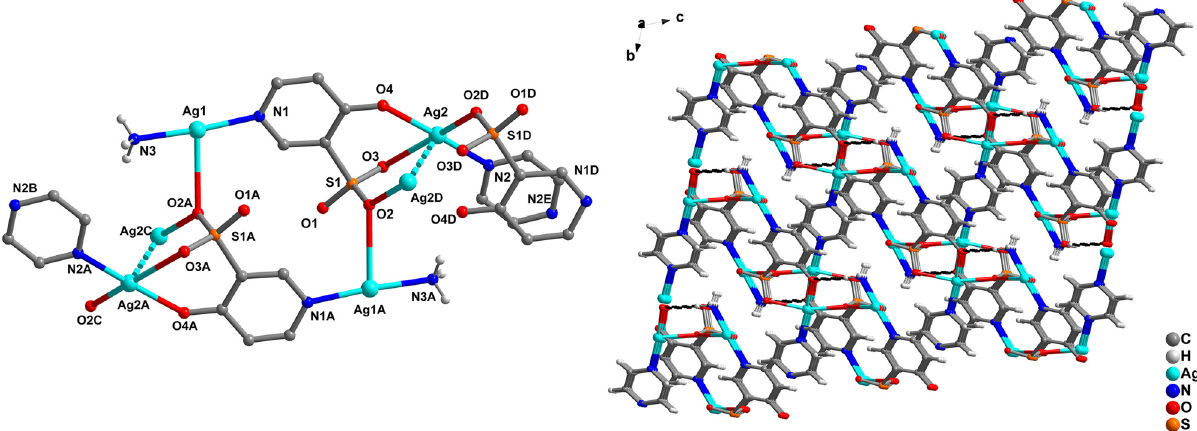
Table  : Data collection and